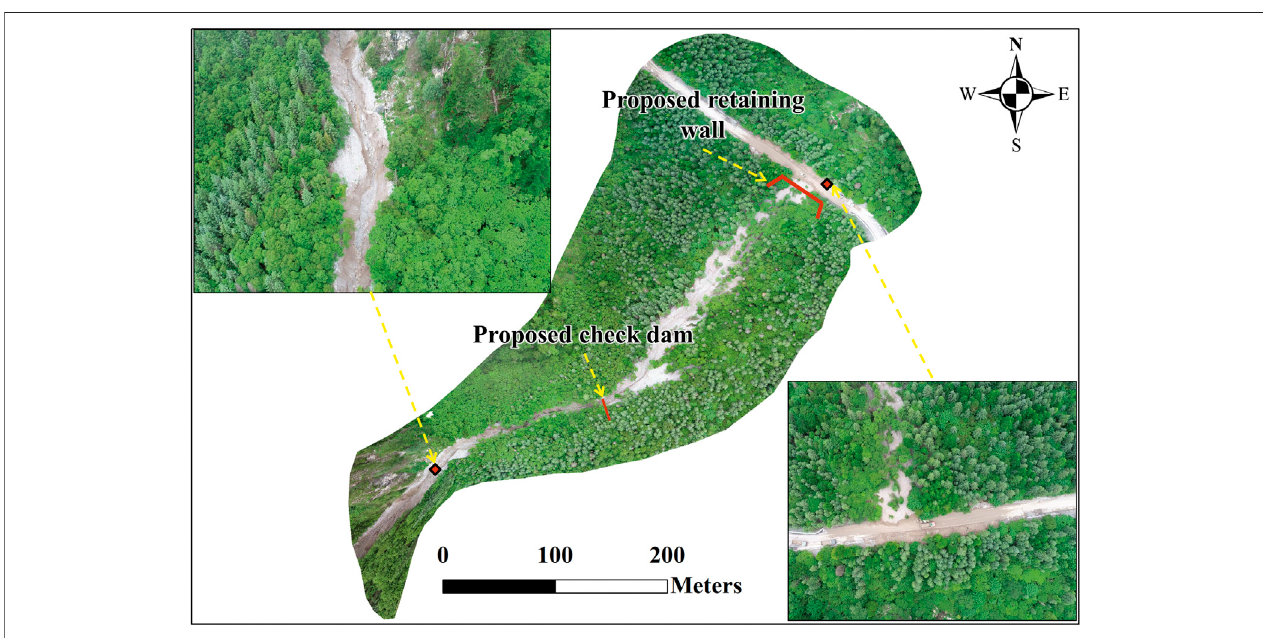
FIGURE 8 | UAV image of the debris fl ow disaster in West-Zhuozhui Gully on June 21, 2019. The check dam and retaining wall in the fi gure are the proposed engineering projects described in Application of the Planning Method for the Xiajijie Lake, Zhuozhui, Pingshitou, Xuan, and West-Zhuozhui Debris Flow Gullies section.